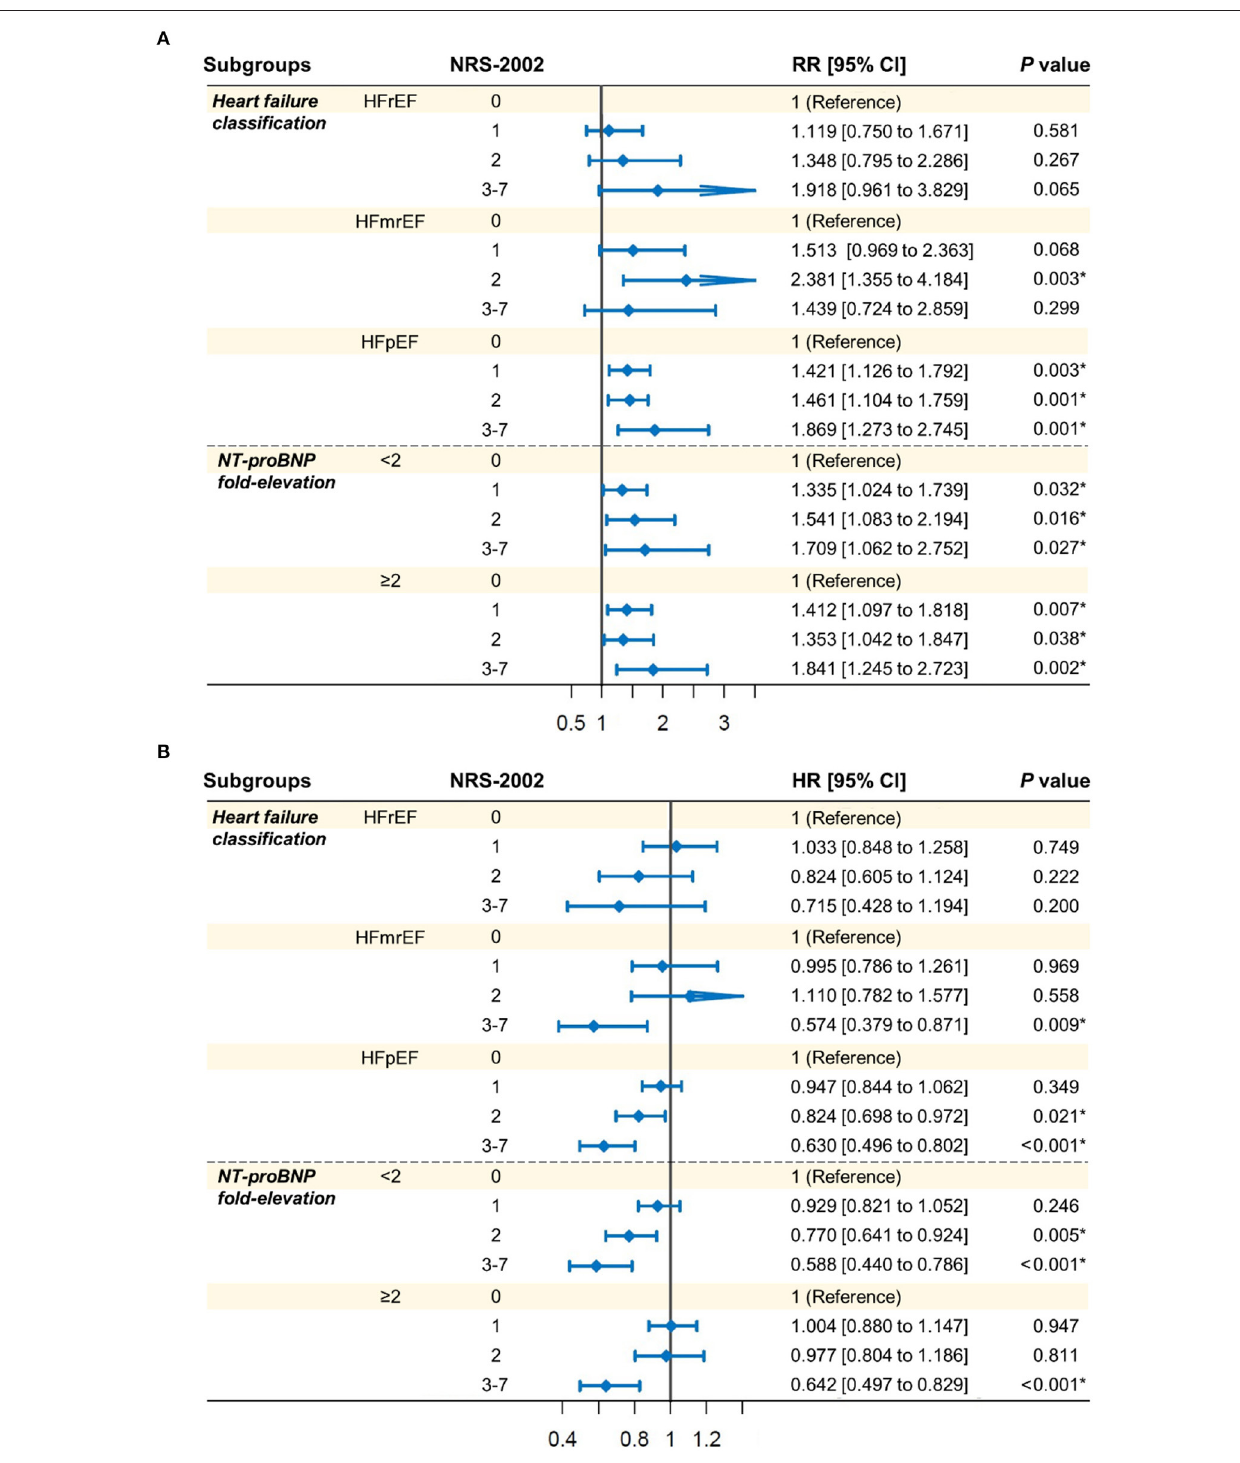
Frontiers in Nutrition |